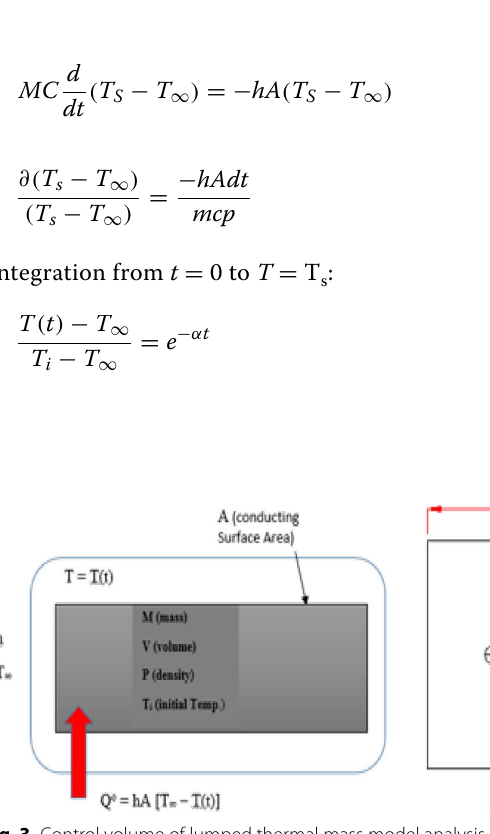
Fig. 3 Control volume of lumped thermal mass model analysis of impingement